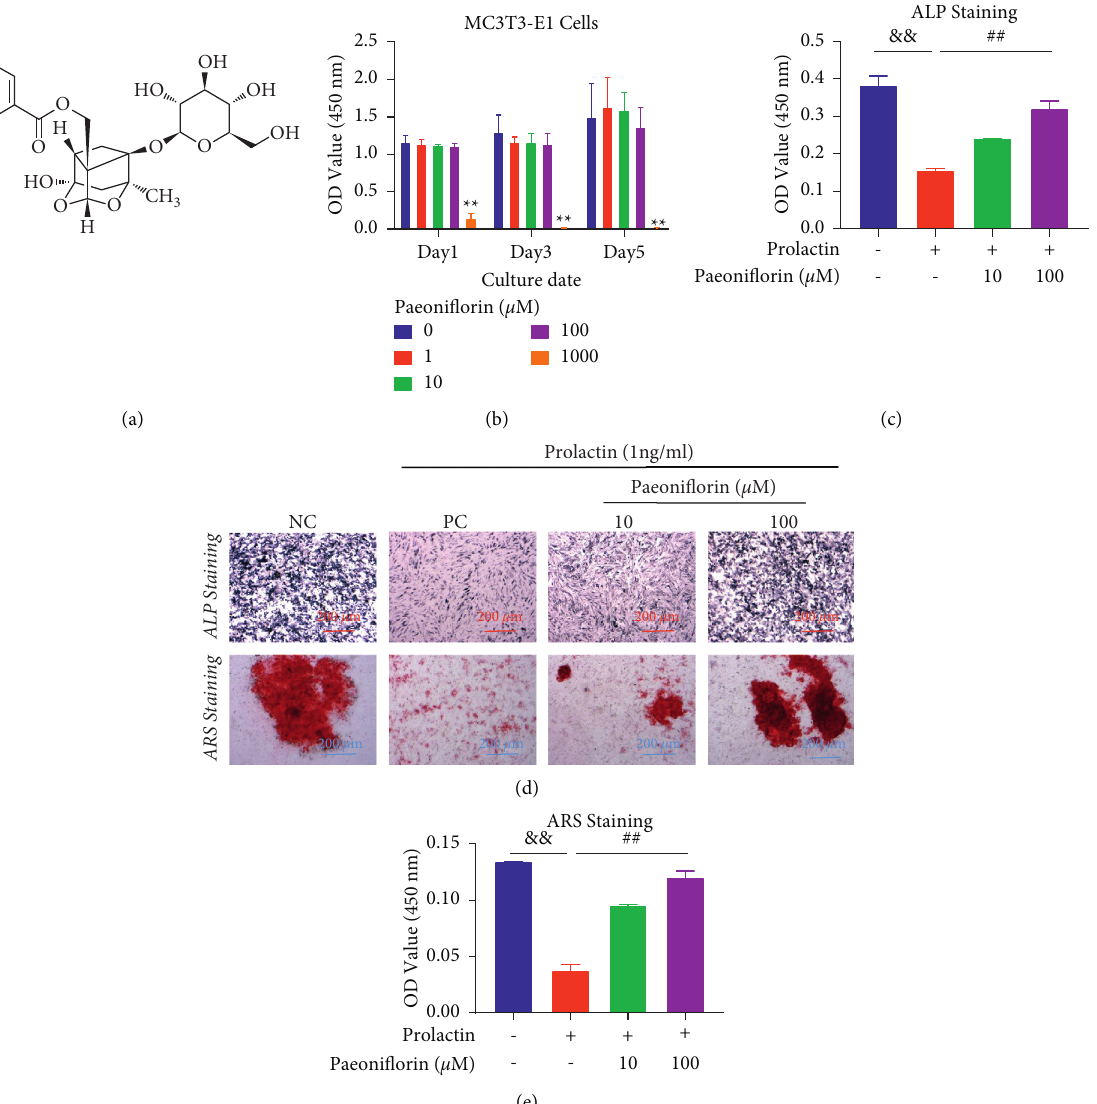
Figure 3: Paeoniflorin ameliorated HPRL-induced osteoblast differentiation inhibition in vitro. (a) The structure of PF. (b) A CCK-8 assay was performed to evaluate cell viability. (c) Representative images of ALP and ARS staining. (d) The ALP-positive cells in each group were quantified. (e) Quantification of ARS-stained cells and mineral nodules. n � 3; scale bar � 200 μ m; ∗∗ P < 0 . 01, ∗ vs the 0 ng/ml group; && P < 0 . 01, & vs the NC group; ## P < 0 . 01, # vs the PC